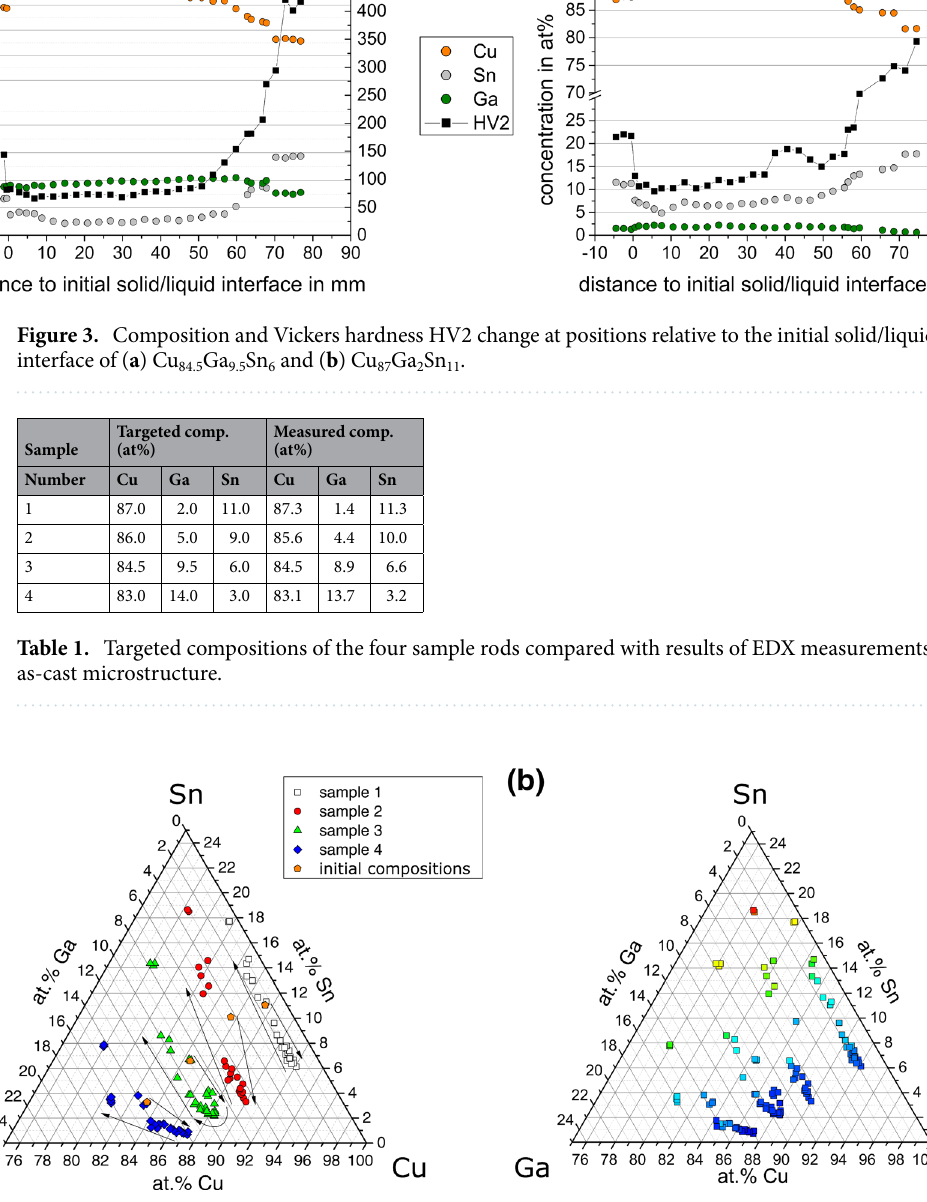
Figure 4. Cu-rich corner of the Cu–Ga–Sn system with ( a ) solidification paths of the gradient samples with arrows indicating the direction of change, and ( b ) Vickers hardness